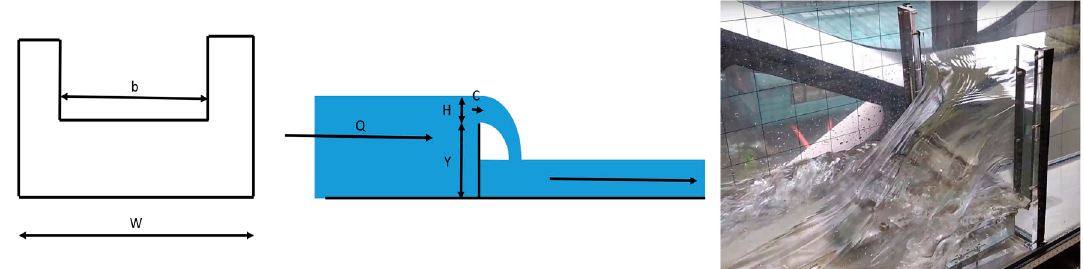
Figure 2. Dimensions used in weir calculations and the experimental apparatus.